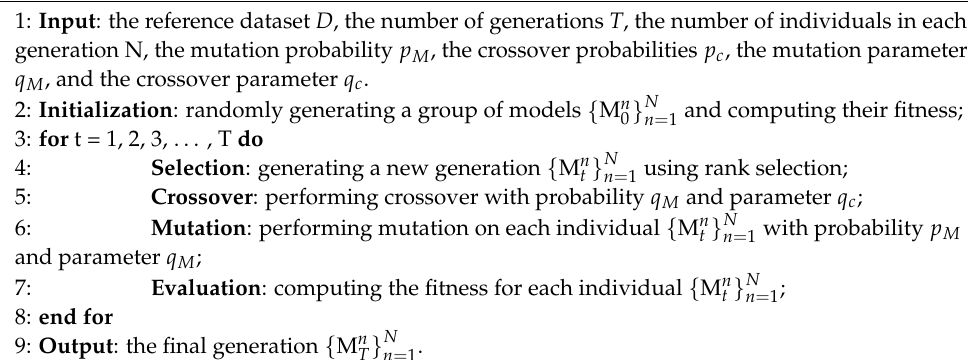
Algorithm 1 The Genetic Process for